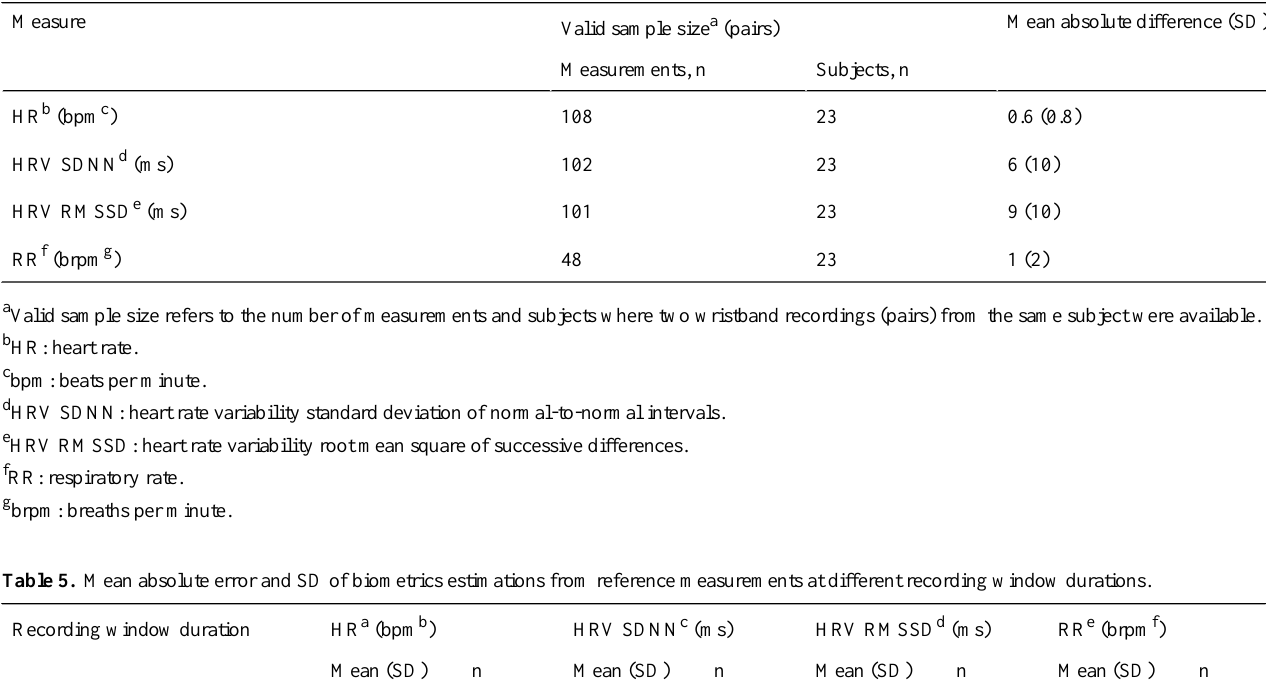
Table 4. The pairwise mean absolute difference between the left and right wristbands.